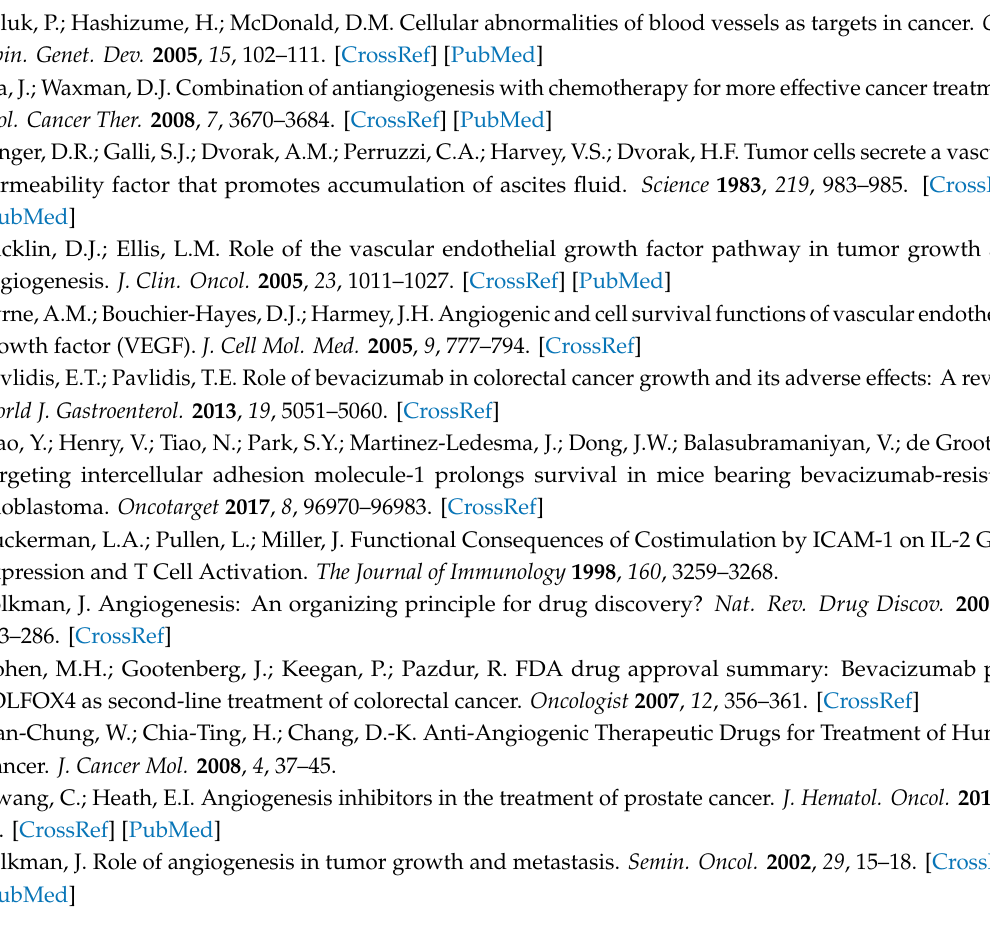
Prediction-corrected visual predictive checks (VPC) of the pharmacokinetic model developed for bevacizumab using 1000 Monte Carlo simulations. Median (solid line), 10th, and 90th percentiles (blue line) of the observed data overlaid to the 95% confidence intervals (colored areas) for the median, 10th, and 90th percentiles of the simulated data, Figure S4. Observed VS Predicted for the PK model., Figure S5. Prediction-corrected visual predictive checks (VPC) of the binding (QSS) model developed for bevacizumab (A) and VEGF (B) using 1000 Monte Carlo simulations. Median (solid line), 10th, and 90th percentiles (blue line) of the observed data overlaid to the 95 % confidence intervals (colored areas) for the median, 10th, and 90th percentiles of the simulated data., Figure S6. Observed VS Predicted for the TMDD model (right Bevacizumab in nM), (left VEGF in nM)., Figure S7. Schematic representation of the PK / PD model developed in the present analysis. Inf: administration of bevacizumab by infusion, V1: the volume of distribution in the central compartment, CL: the clearance of elimination, Q: the inter-compartmental clearance, V2: the volume of distribution of second compartment, C(t): Concentration of bevacizumab in the central compartment, E0: VEGF levels before bevacizumab administration, E(t): free-VEGF levels that have not been neutralized after bevacizumab administration., Figure S8. Prediction-corrected visual predictive checks (VPC) of the PK / PD model developed for bevacizumab (A) and VEGF (B) using 1000 Monte Carlo simulations. Median (solid line), 10th, and 90th percentiles (blue line) of the observed data overlaid to the 95 % confidence intervals (colored areas) for the median, 10th, and 90th percentiles of the simulated data., Figure S9. Observed VS Predicted for the PK / PD model (right Bevacizumab in mg / mL), (left VEGF in ng / mL). Table S1: Gender vs. SNPs, Table S2. ICAM-1 rs1799969 vs. SNPs, Table S3. ICAM-1 rs5498 vs.